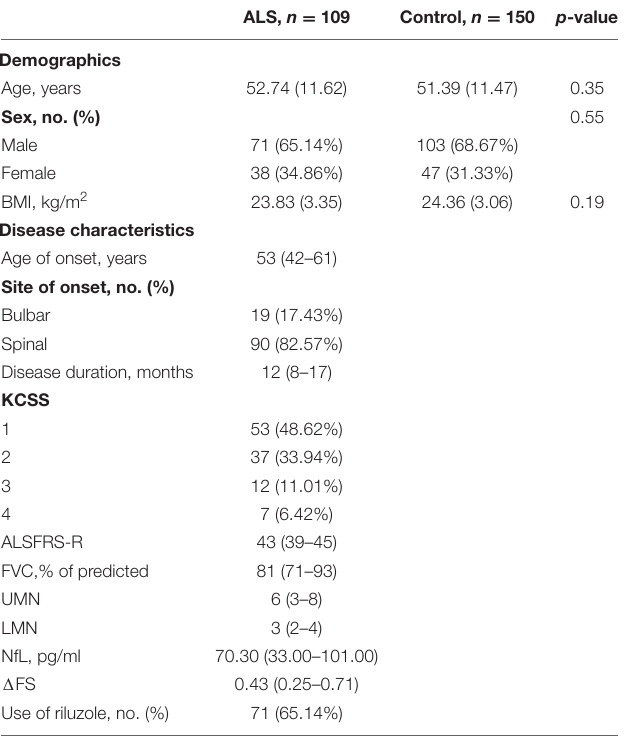
TABLE 1 | Baseline characteristics of ALS and controls.